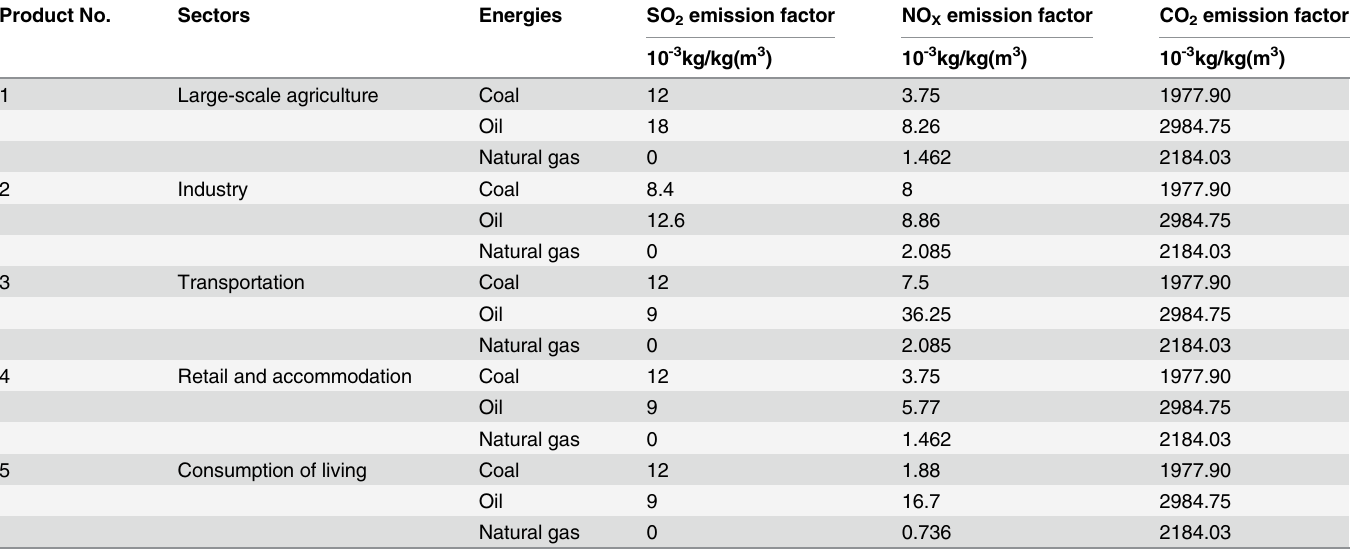
Table 2. Pollution Discharging